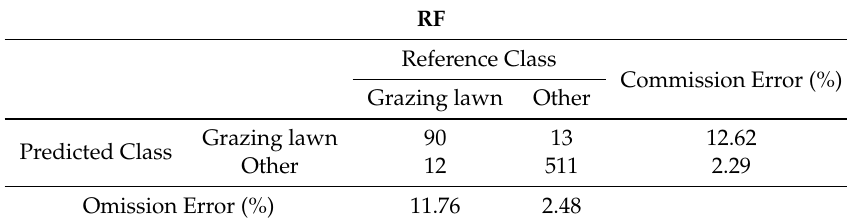
Table A6. Confusion matrix summarising results from Random Forest (RF) model classification of grazing lawn and other cover.